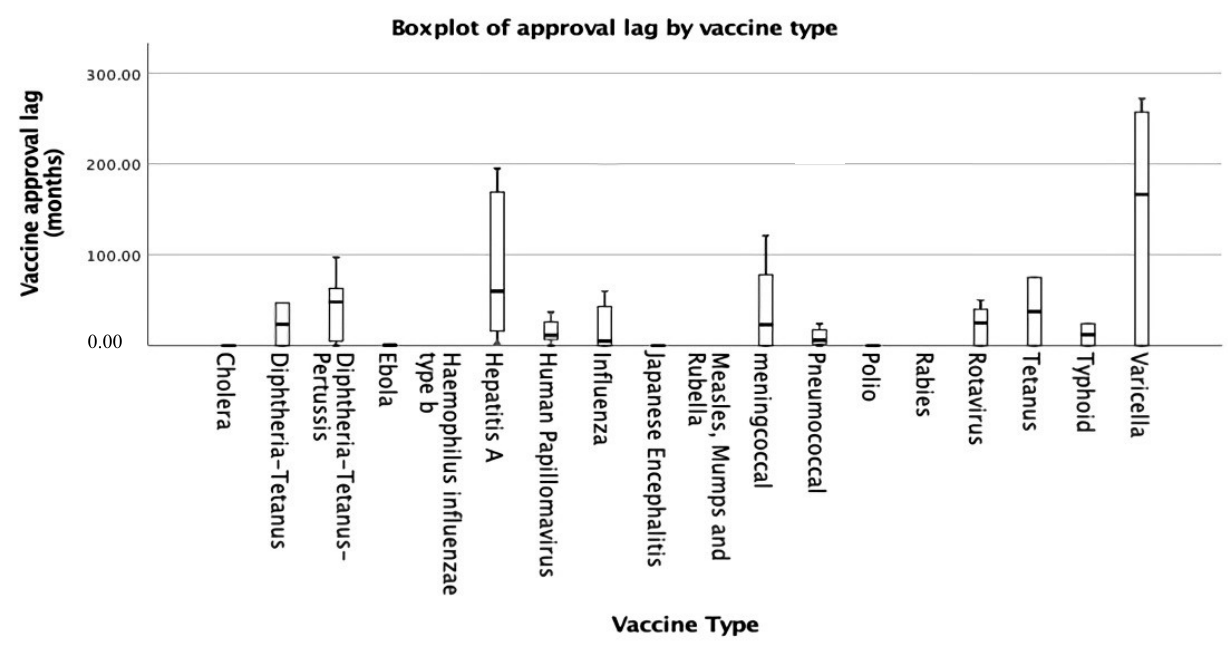
Figure 4. Clustered boxplot of vaccine relative approval lag divided by the first approval NRAs. Table 4. Relative approval lag for WHO prequalified vaccines divided by the first approval NRAs. ( n =